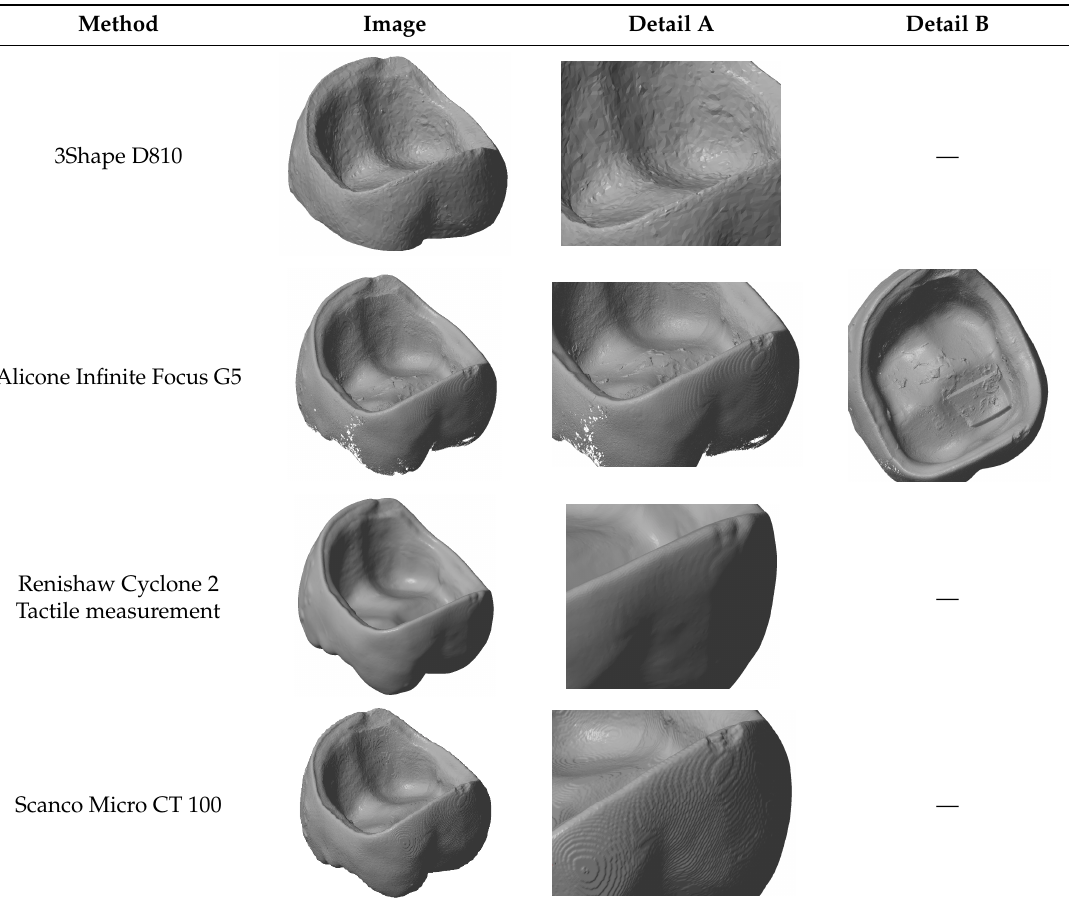
Table 3. Images of crown A obtained with di ff erent scan